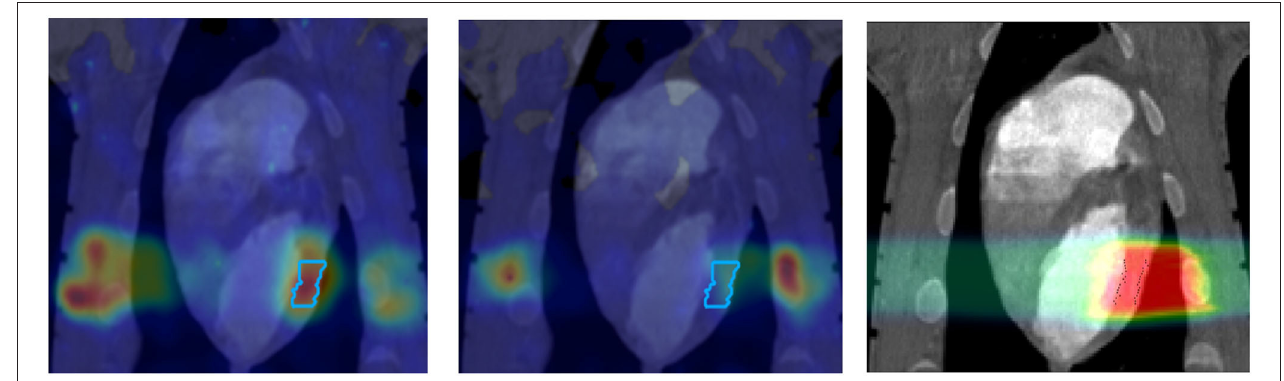
FIGURE 3 | PET images of a pig heart treated with 12 C-ions. The ventricular target is drawn in the treatment planning image overlaid to the CT (Right) . Online PET image (Left) was acquired during the treatment at GSI, while the offline (center) was registered 20min after the treatment. PET imaging obtained with the online PET camera at GSI, courtesy of Helmholtzzentrum Dresden (HZDR); details in Ref.